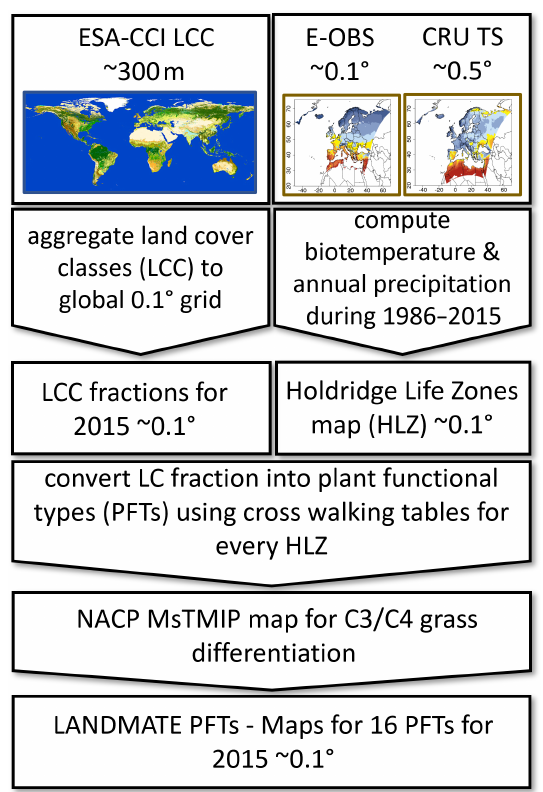
Figure 1. The general workflow to generate LANDMATE PFT 2015 Version 1.0. This workflow is part of the workflow to gen- erate the LUCAS LUC time series as introduced in the companion paper by Hoffmann et al.